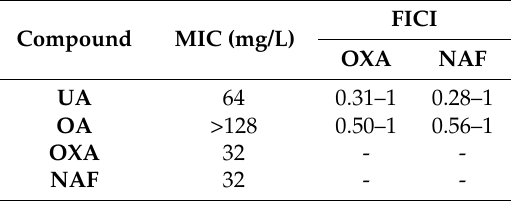
Table 2. Antimicrobial activity of ursolic acid (UA), oleanolic acid (OA), oxacillin (OXA) and